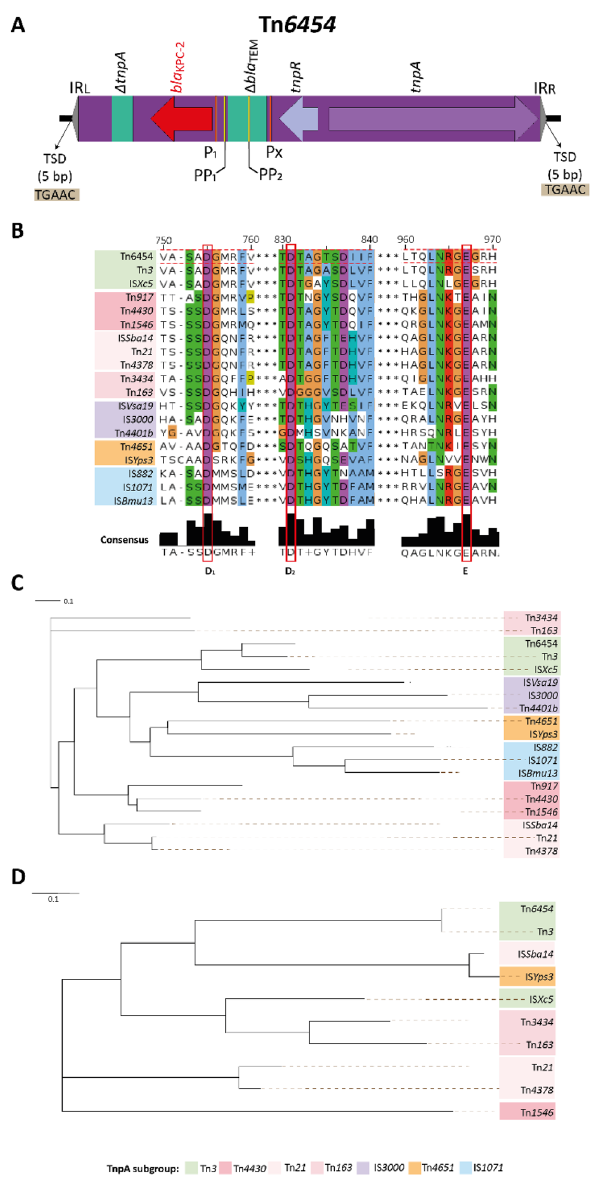
Figure 4. Tn 6454 characterization. ( A ) General structure of Tn 6454 . The arrows indicate the open reading frames, the coding regions for transposases (purple), resolvases (lilac), resistance genes (red) and truncated genes (green) are highlighted, the transposons are delimited in a purple rectangle. The inverted repeats are little gray arrows and the duplication sites (TSDs) generated by the transposition were illustrated inside a gray rectangle. Promoters of bla KPC gene are indicated by orange and yellow lines, the orange lines indicate the promoters P1 AND PX and the yellow lines the putative promoters PP1 (− 10 ttttaattt, − 35 ttgatt) and PP2 (− 10 taatagact, − 35 tagctt) with a linear discriminant function (LDF) of 7.99 and 0.78, respectively. ( B ) Multiple sequence alignment of Tn 3 -family transposase proteins, the numbers correspond to alignment positions in aa and the dotted lines showed the DDE motif. Insertion sequences representative of diversity of IS Kra4 family are indicated on the left. (C) Phylogenetic NJ tree of the Tn 3 -family transposase proteins and (D) S-recombinase family proposed by Nicolas et al. 37 . The different clusters and subgroups identified within the family are boxed with different colors as indicated. The length of the branches is proportional to the average number of substitutions per